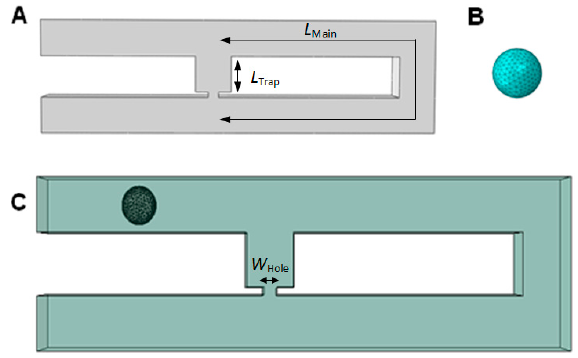
Figure 11. Construction of the finite element model of single-cell trapping system and parts involved: ( A ) Eulerian part (fluid channel’s top view) L Main represents the main channel’s length and L Trap represents the trap channel’s length; ( B ) 3D deformable part (yeast cell model); ( C ) simulation’s assembly setup (cell is positioned between inlet and trap channel as initial position). W Hole represents trap hole’s width.